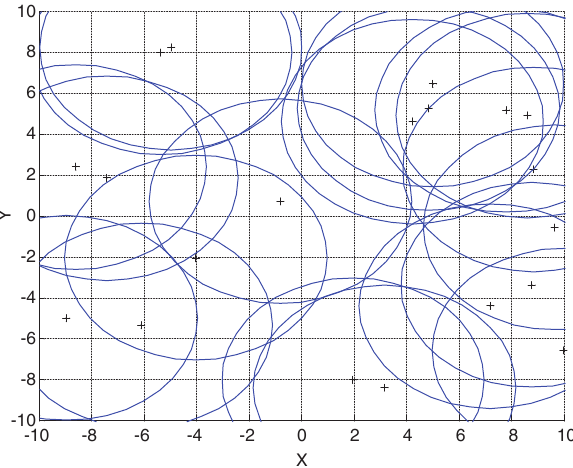
Figure 10: The Node Layout When the Node Sensing Radius Was 5.